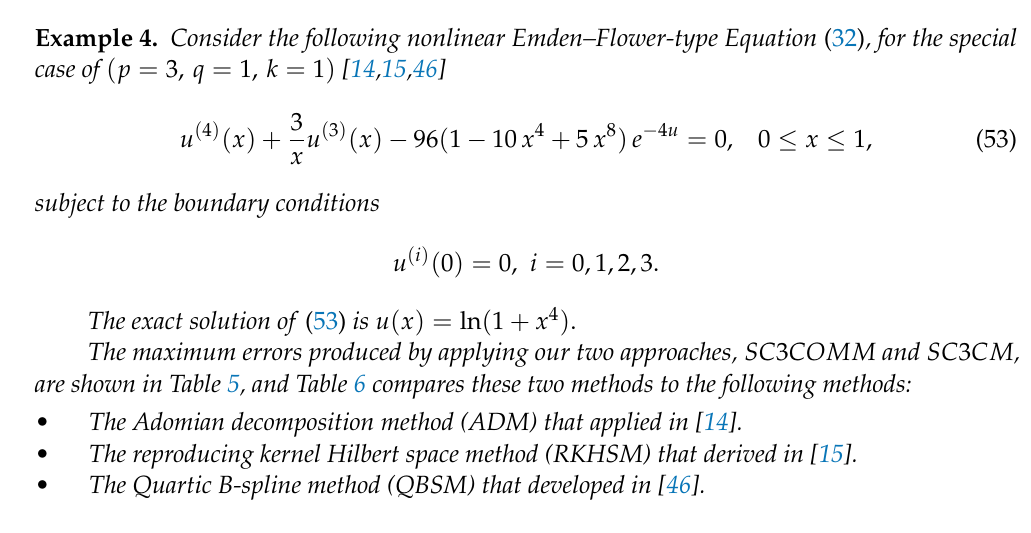
Figure 2. Comparison between the errors of Example 3 for N = 3,4, . . .